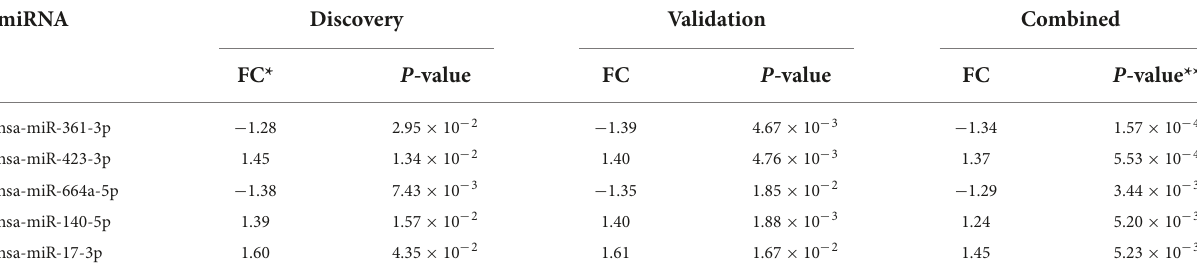
TABLE 1 Differentially regulated miRNAs in SWDM compared to SWoDM patients. miRNA Discovery Validation Combined FC* P -value FC P -value FC P